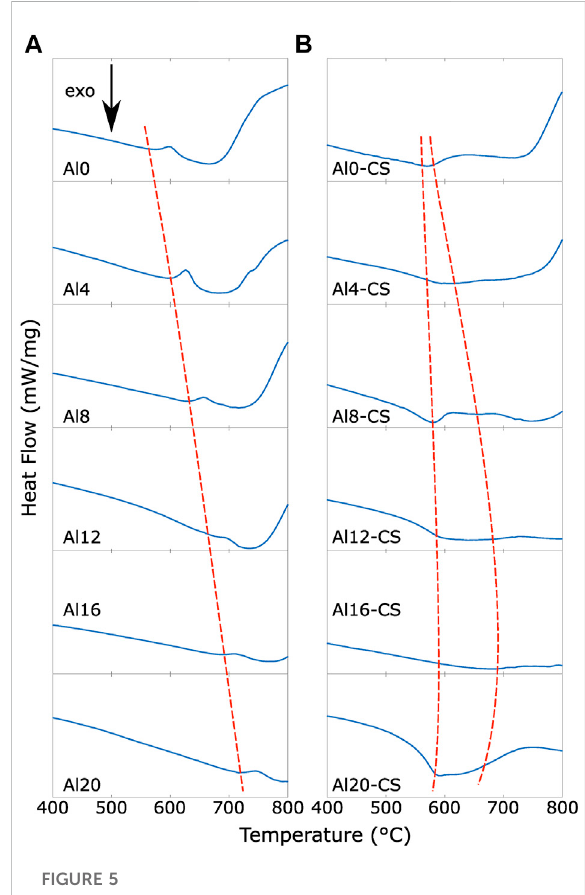
FIGURE 5 DTA graphs for (A) Al0 – 20 glass powder and (B) CS Al0 – 20 glass powder. The red dashed lines are guides for the eye showing the